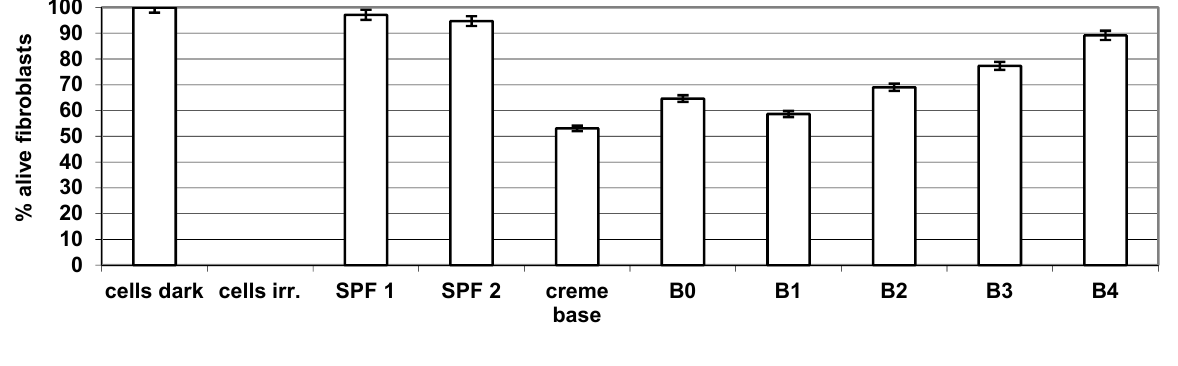
Figure 2. Photoprotector capacity (% alive fibroblasts) of SPFs commercial formulations compared with boldine derivatives B1 – 4 .